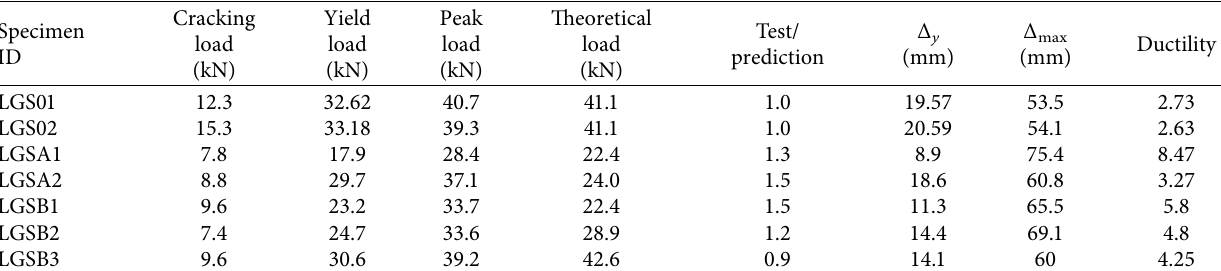
Table 3: Characteristic properties of LGS